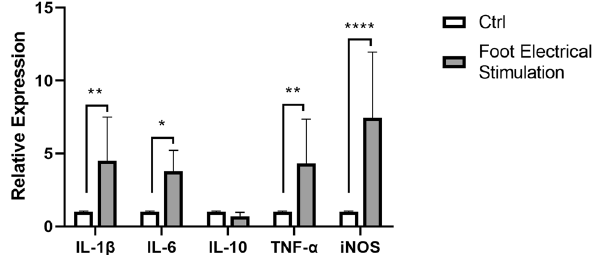
Figure 6. The levels of IL-1β, IL-6, IL-10, TNF-α, and iNOS gene in duodenum of control and experimental group were detected by PCR. All data are presented as mean ± SD (n = 12). * P < 0.05 versus control group, ** P < 0.01 versus control group, **** P < 0.001 versus control